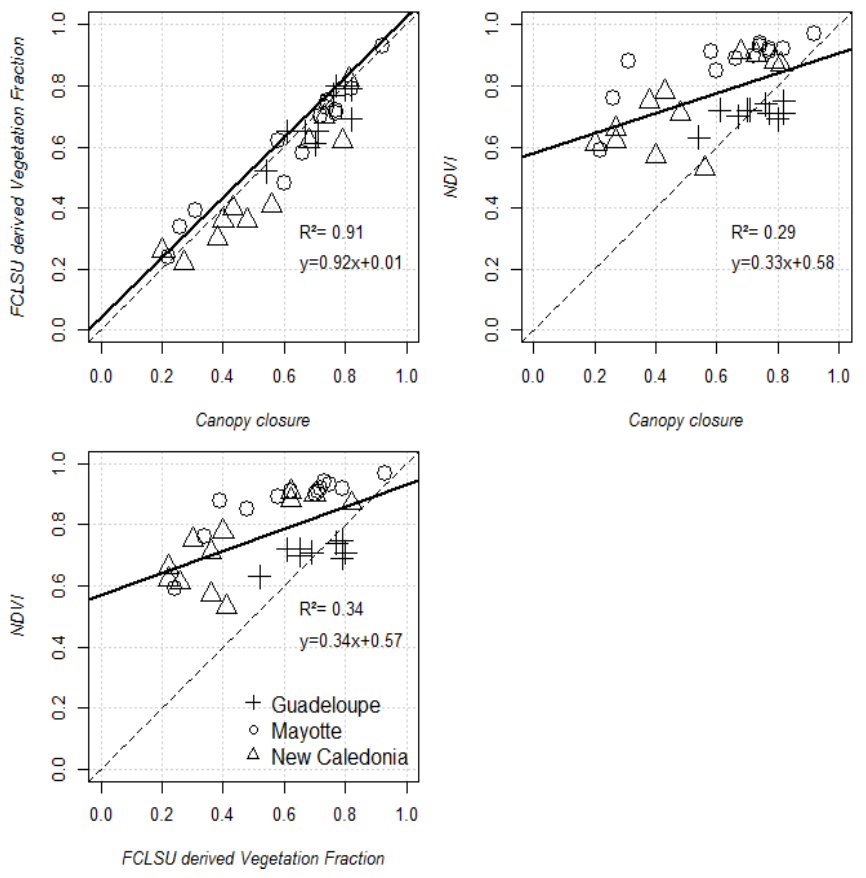
Figure 4. Relationships between FCLSU-derived vegetation fraction values and canopy closure estimates from hemispherical photographs ( left ) and NDVI values ( right ). The continuous line indicates the best linear model between each pair values.